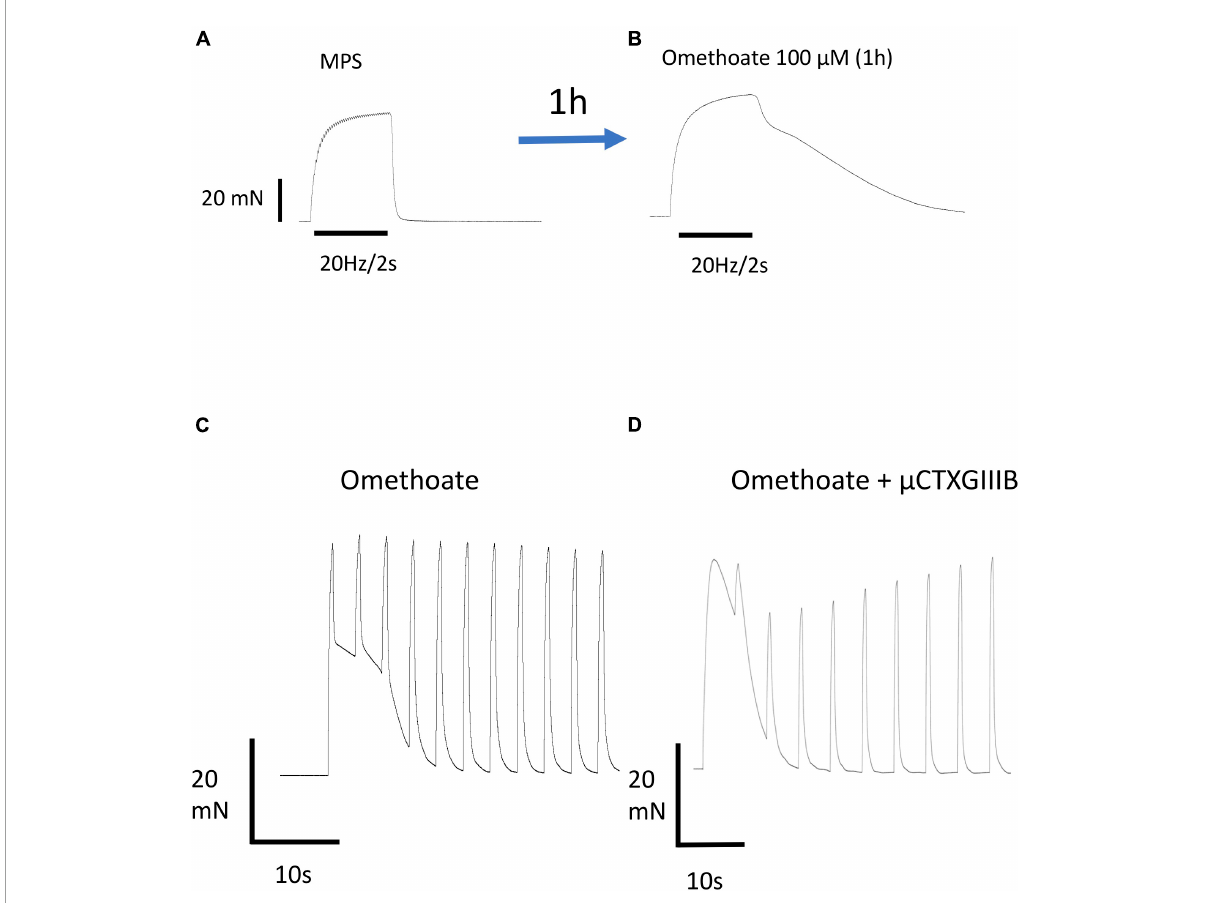
FIGURE1 Omethoate induces prolonged aftercontractions. (A) Response of an isolated FDB muscle to repetitive stimulation at 20 Hz for 2 s. The partially fused tetanic response relaxes promptly at the end of the stimulus train. (B) Same preparation 1 h after incubation in 100 µ M omethoate. A similar tetanic stimulus train produced a fused tetanus with a complex profile of prolonged relaxation (“aftercontraction”). (C) Aftercontractions have a long refractory period. Response of a different FDB preparation incubated for 1 h in 100 µ M omethoate, stimulated at 40 Hz for 0.5 s approximately every 5 s. The first response comprises a brief tetanus followed by a prolonged aftercontraction. Successive tetanic stimulus trains caused force production during stimulation, summating with the relaxing phase of the aftercontraction due to the first train, but induced no aftercontractions. (D) Different preparation stimulated with a similar pattern of tetanic trains but co-incubated in 2 µ M µ CTX-GIIIB to block muscle action potentials and 100 µ M omethoate for 1